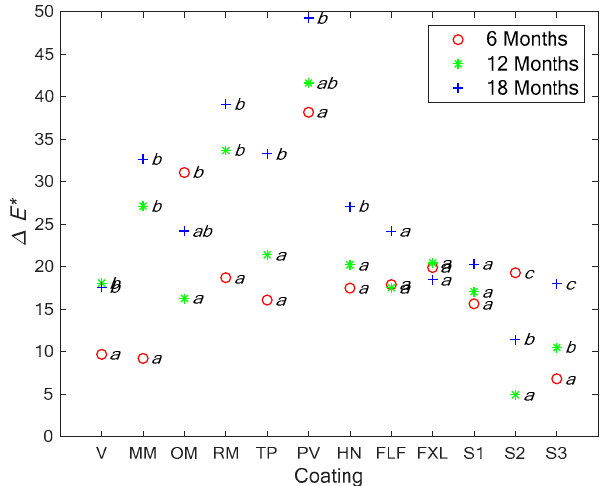
Figure 19. Games–Howell pairwise mean differences of color change for ponderosa pine wood for each coating during the study. Superscripts with the same letter indicate means between intervals that are not significantly different at the p < 0.05 level.